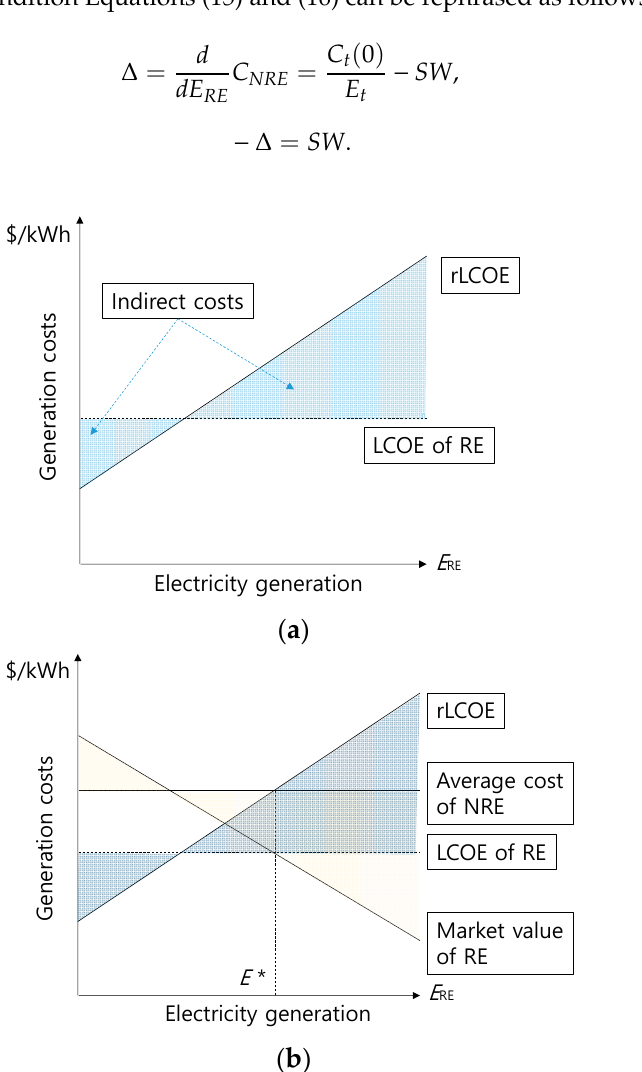
Figure 1. The principle of rLCOE with optimal RE deployment. ( a ) Relationship with rLCOE and RE deployment. ( b ) Correlation with rLCOE and market value.